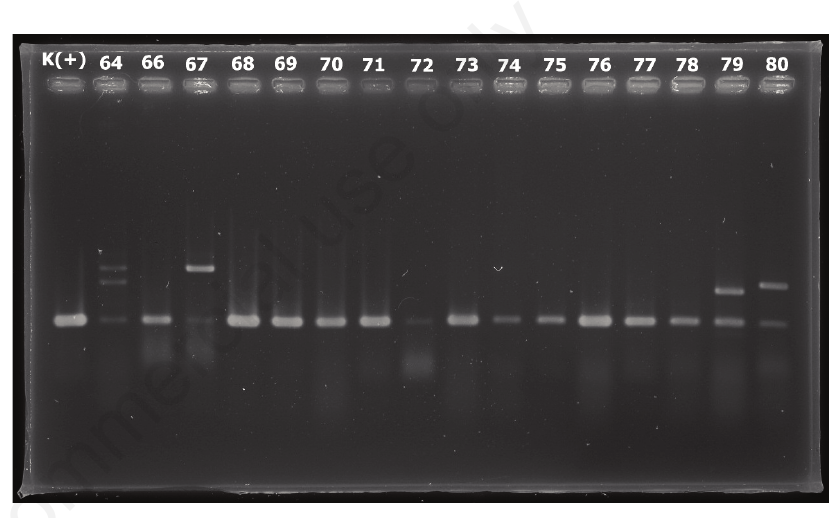
Figure 1. PCR amplification using primer AAIC.